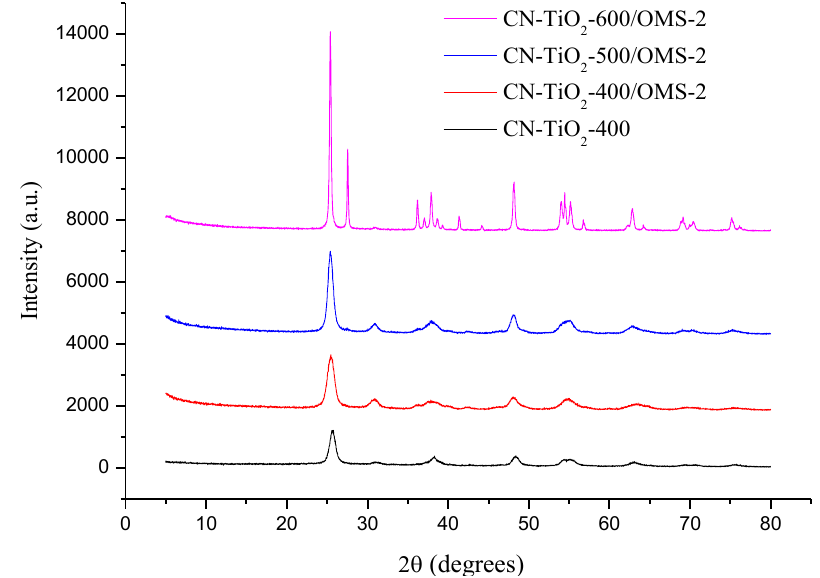
Figure 1. XRD patterns of as-prepared reference and CN-TiO 2 /OMS-2 nanoparticles calcined at different